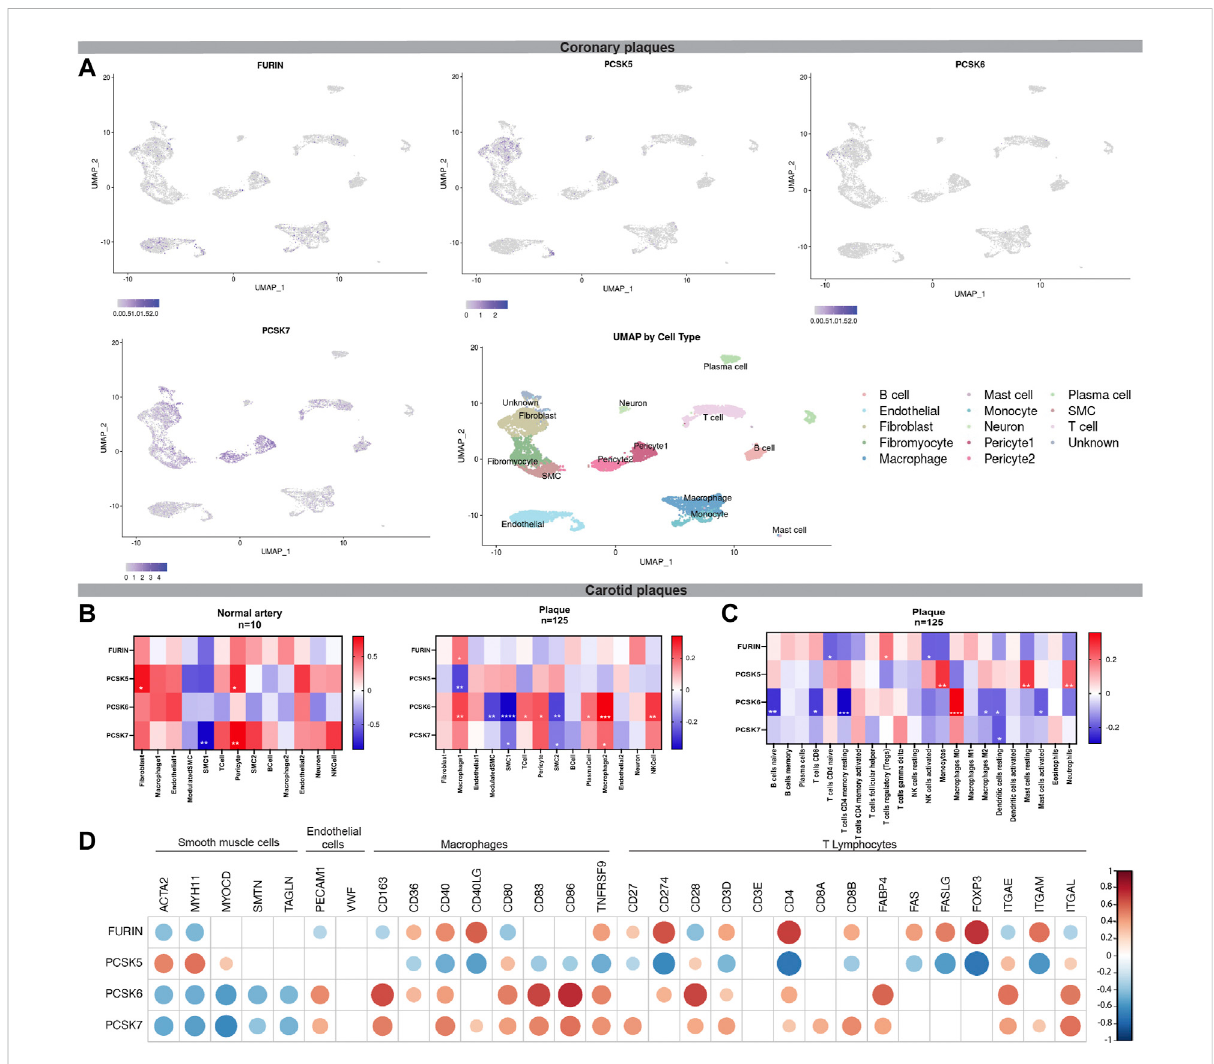
FIGURE 5 Single cell analysis of FURIN and PCSK5-7 expression in atherosclerotic lesions. Public single-cell RNA sequencing data interrogated using Plaqview for the expression of FURIN and PCSK5-7. Data is visualised in t-SNE plots showing cell types that express the respective PCSK in coronary plaques (A) . Heatmaps representing correlation of FURIN and PCSK5-7 expression to major cell type fractions deconvolved from carotid plaque microarray data based on single cell RNA sequencing data from coronary plaques. Squares with stars represent statistically signi fi cant correlations (B) . Heatmap representing correlation of FURIN and PCSK5-7 expression speci fi cally with in fl ammatory cell type fractions in carotid plaques (C) . Correlations of FURIN and PCSK5-7 transcripts to the expression of individual typical cell markers in carotid plaques (D) . t-distributed stochastic neighbour embedding